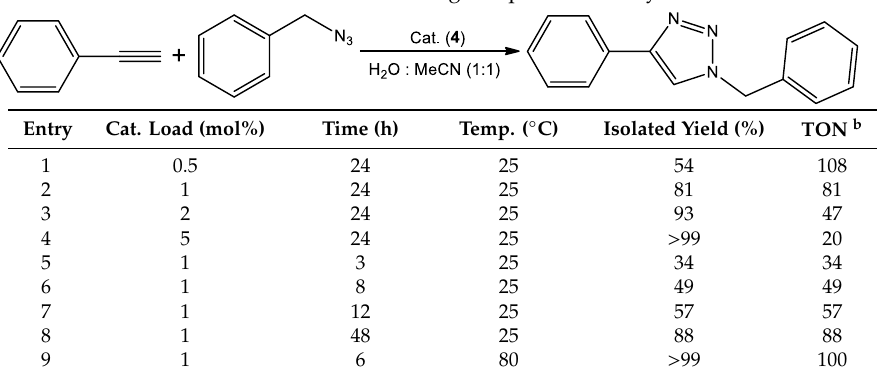
Figure 8. The structure of complex [Cu(μ -CH 3 COO) 2 (κ O- DAPTA=O)] 2 ( 4 ). Table 3. CuAAC reaction using complex 4 as catalyst a.